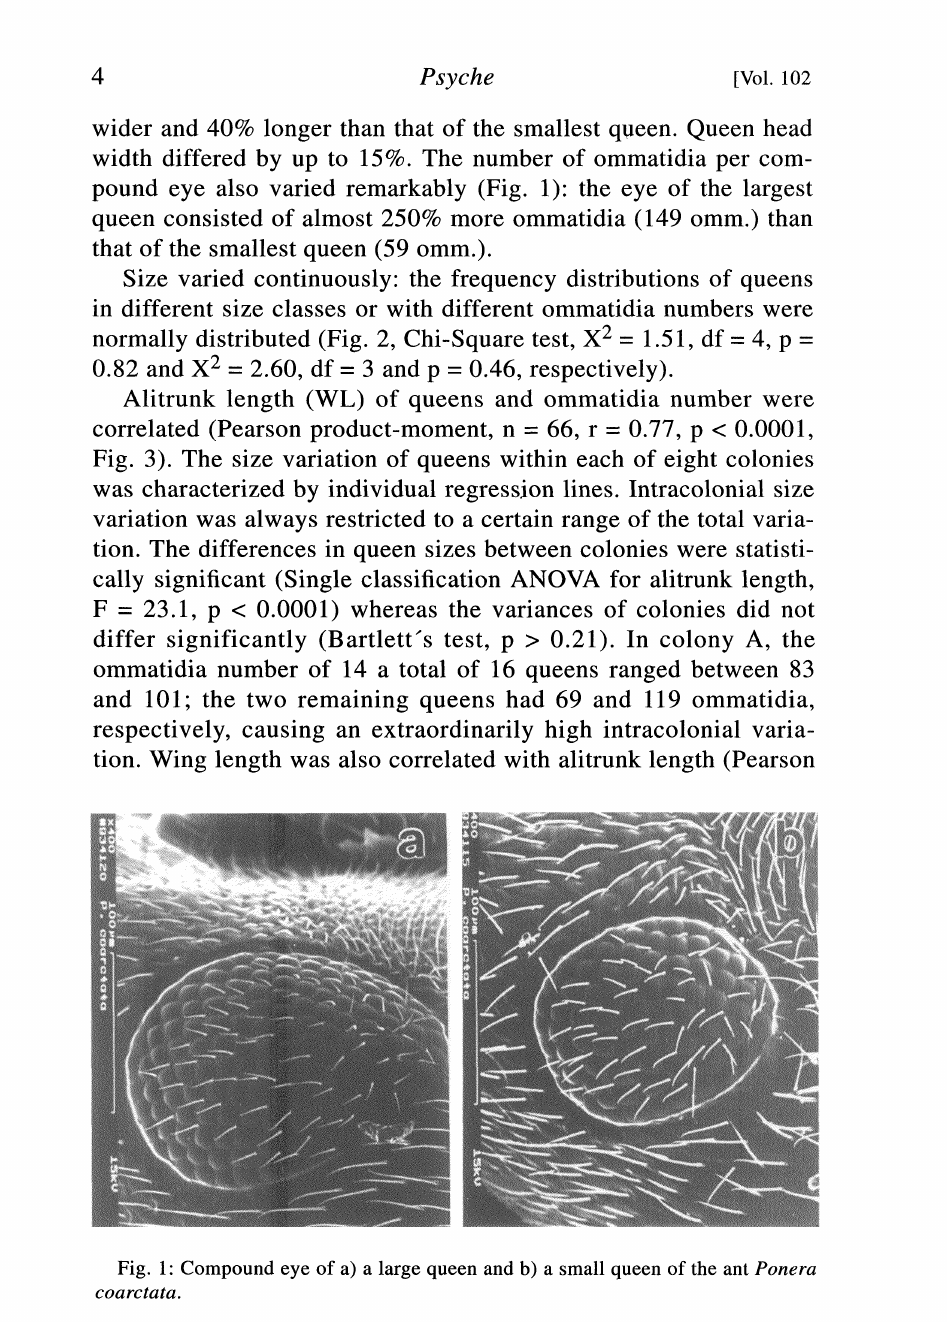
Fig. 1: Compound eye of a) a large queen and b) a small queen of the ant Ponera